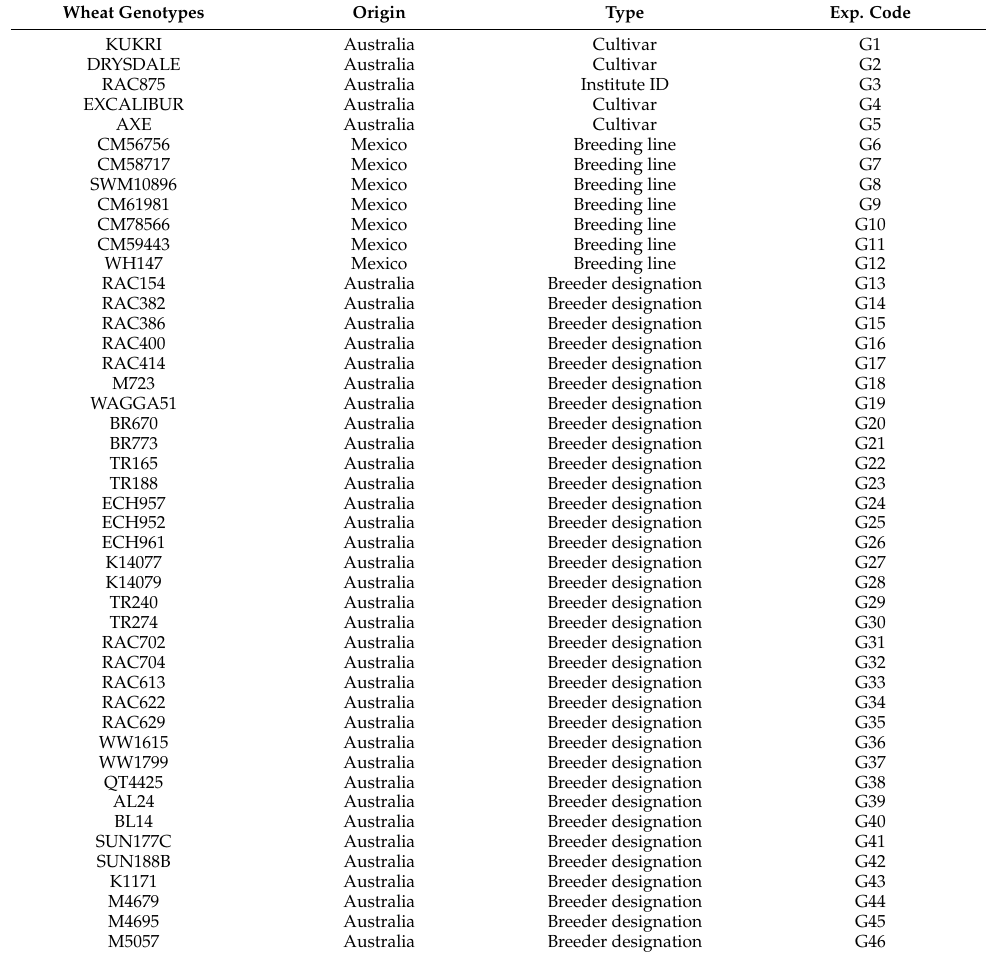
Table 1. List of wheat genotypes used in this